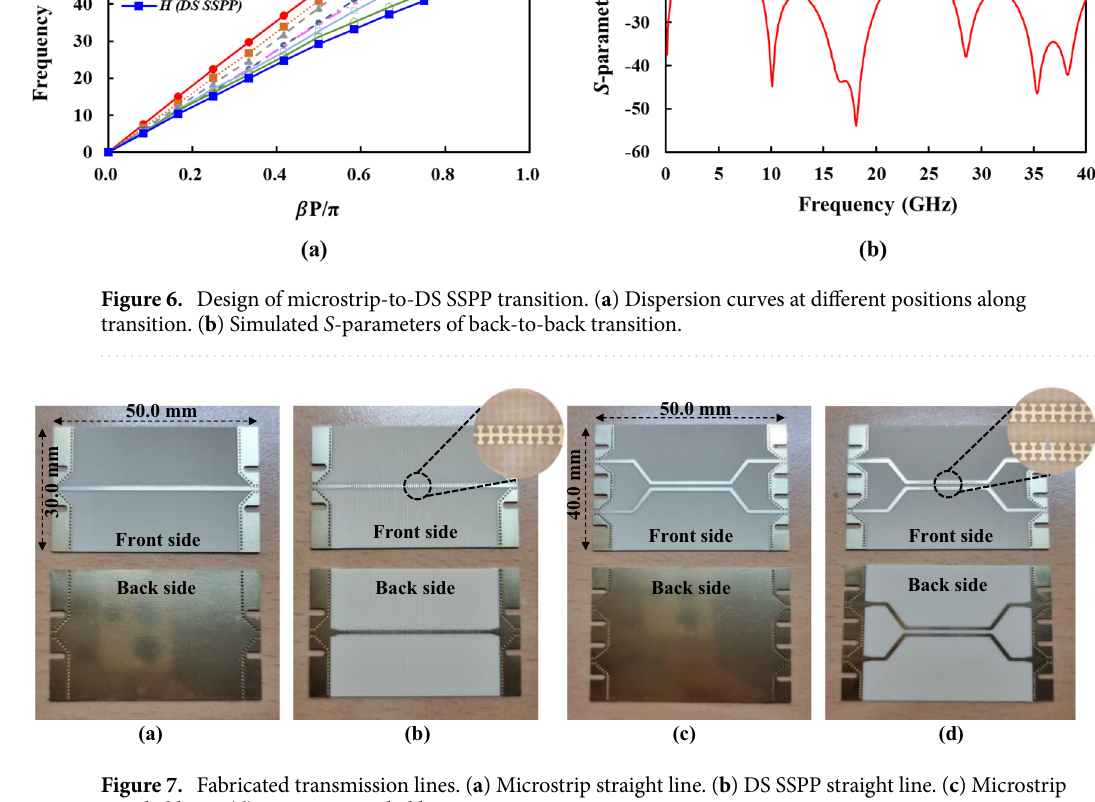
Figure 7. Fabricated transmission lines. ( a ) Microstrip straight line. ( b ) DS SSPP straight line. ( c ) Microstrip coupled lines. ( d ) DS SSPP coupled lines.